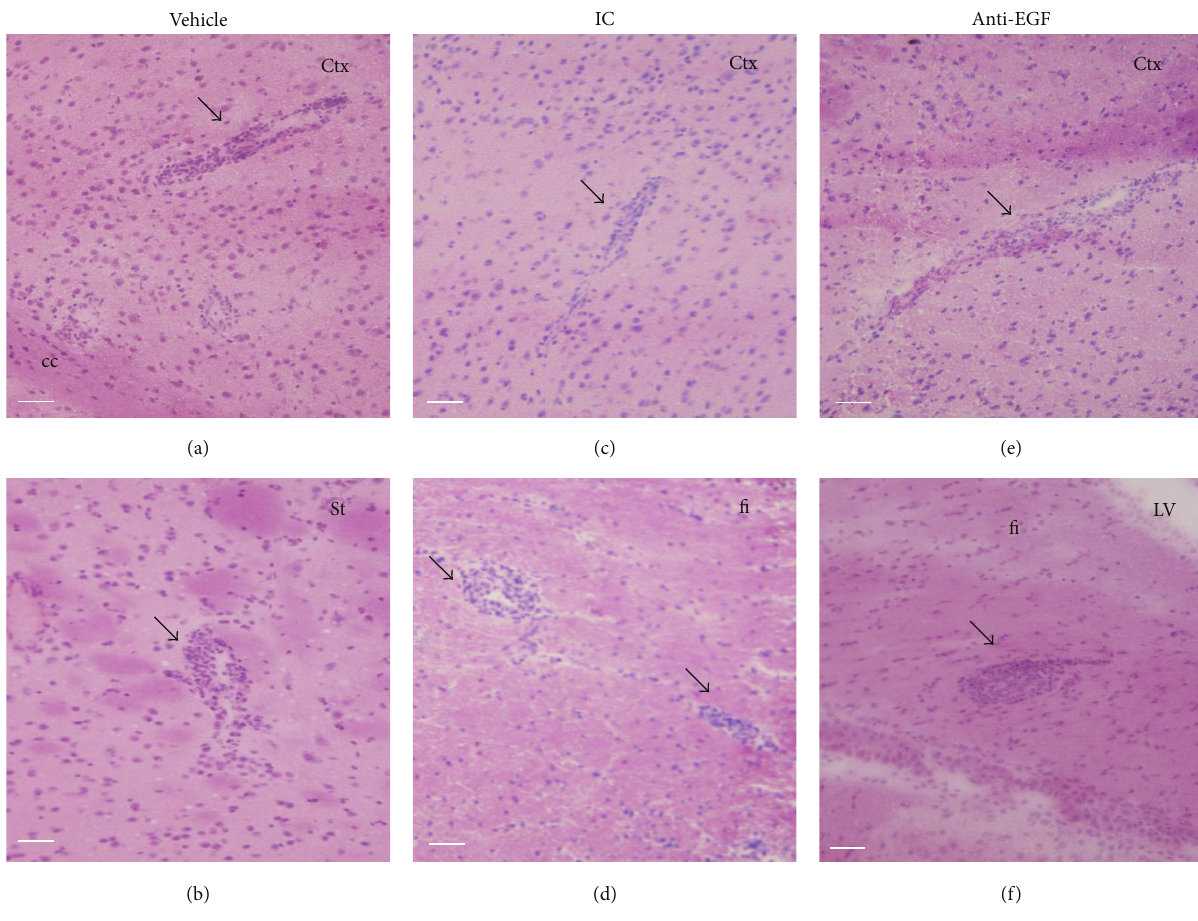
Figure 5: Treatment with anti-EGF Ab did not affect inflammatory cell infiltration into the CNS. Estimation of inflammatory infiltrates on day 18 after immunization by hematoxylin and eosin staining. Infiltrates (arrows) were detected in the cortex and striatum of vehicle-treated EAE mice (a and b), in the cortex and fimbria of IC-treated EAE mice (c and d), and in the cortex and fimbria of anti-EGF Ab-treated EAE mice (e and f). Images were obtained by a light microscope. Ctx , cortex, cc , corpus callosum, St , striatum, fi , fimbria, and LV , lateral ventricle. Scale bar: 50 𝜇